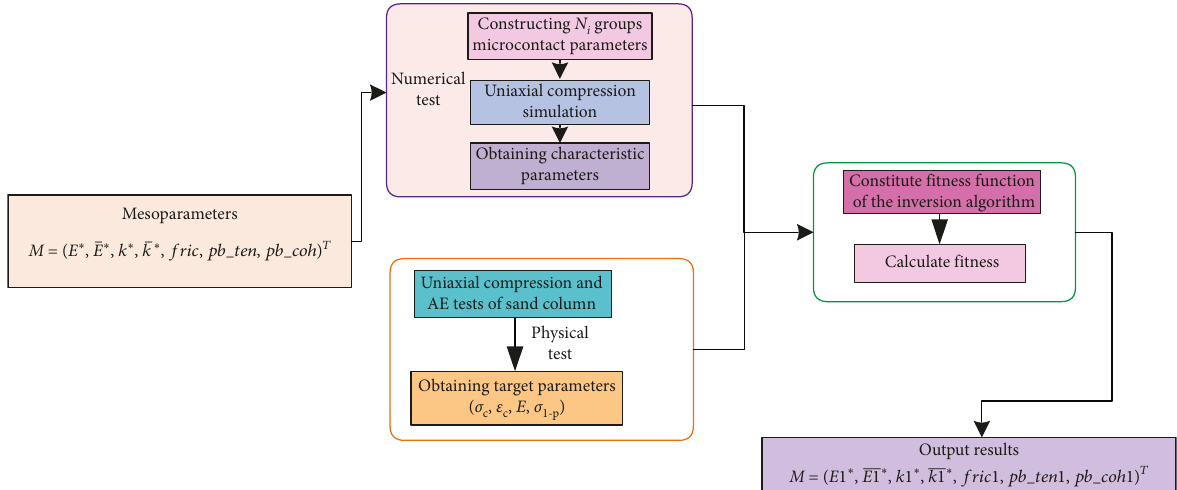
Figure 9: The realisation process of the inversion algorithm of